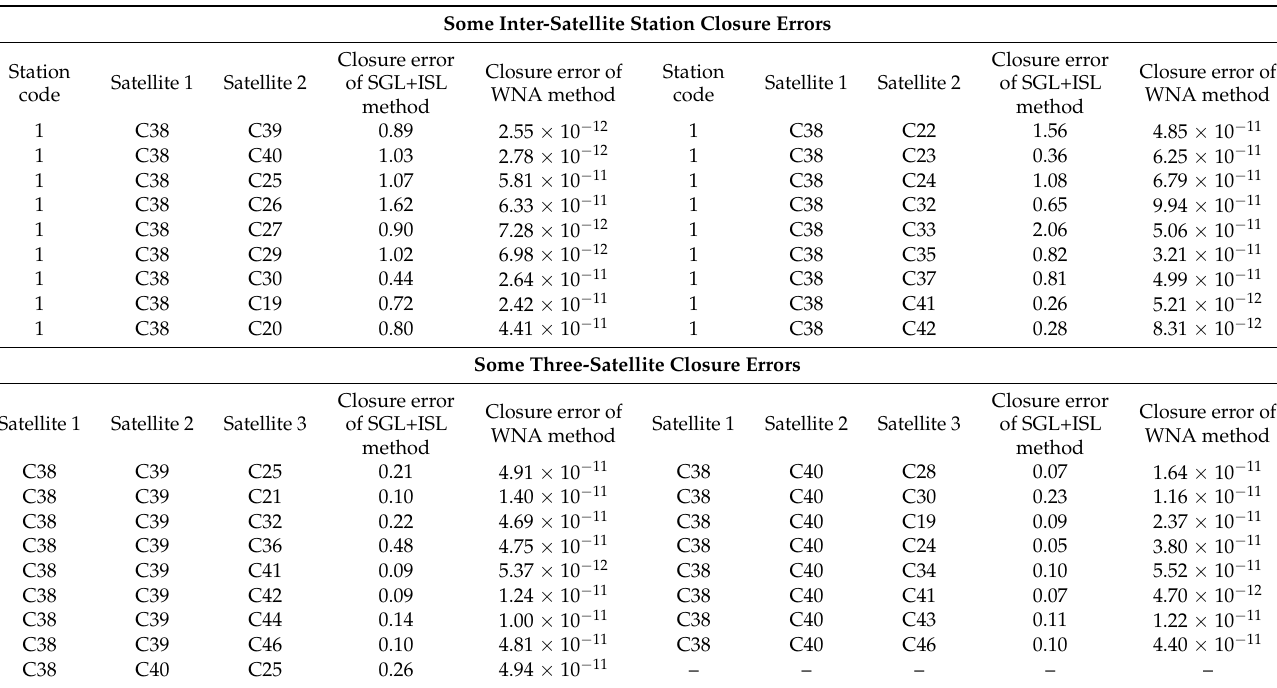
Table 3. RMS statistical results of some inter-satellite station and three-satellite closure errors (unit: ns). Some Inter-Satellite Station Closure Errors